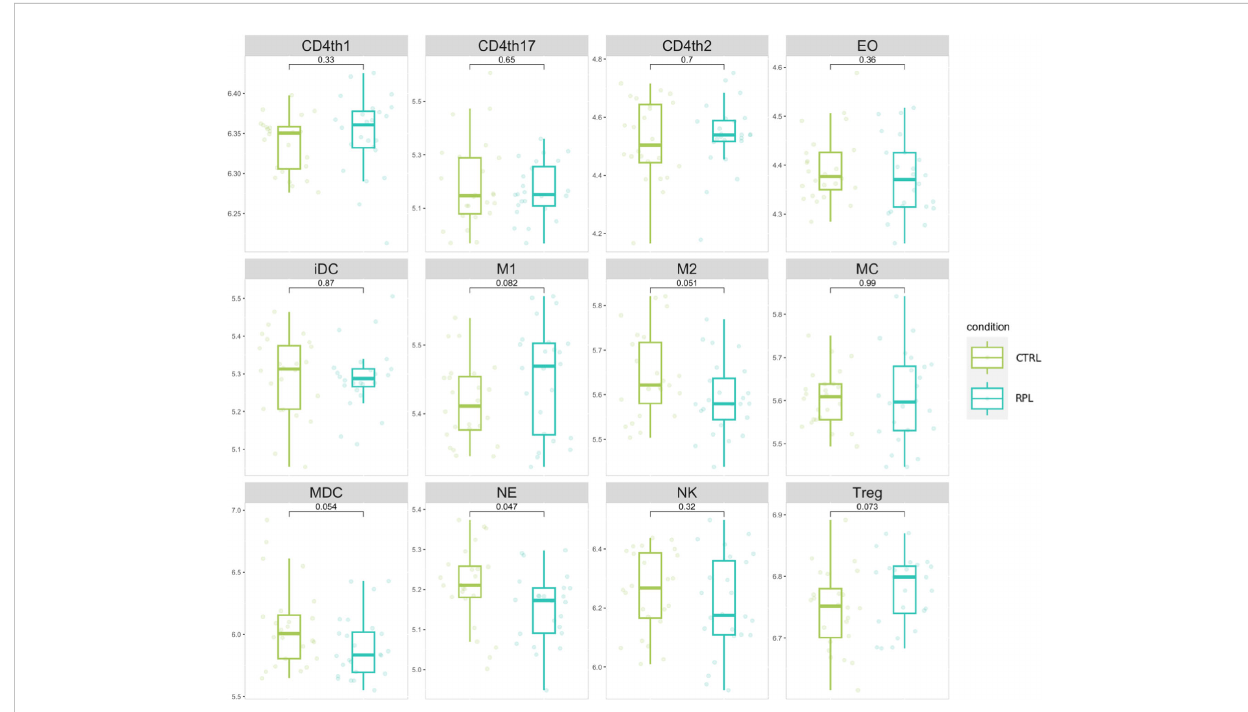
FIGURE 2 Immune cell populations signature distribution comparison. Values represent the gene weighted geometric mean of microarray expression levels, transformed to a log2 scale. The indicated p-values refer to the t-test comparison between RPL and control group.